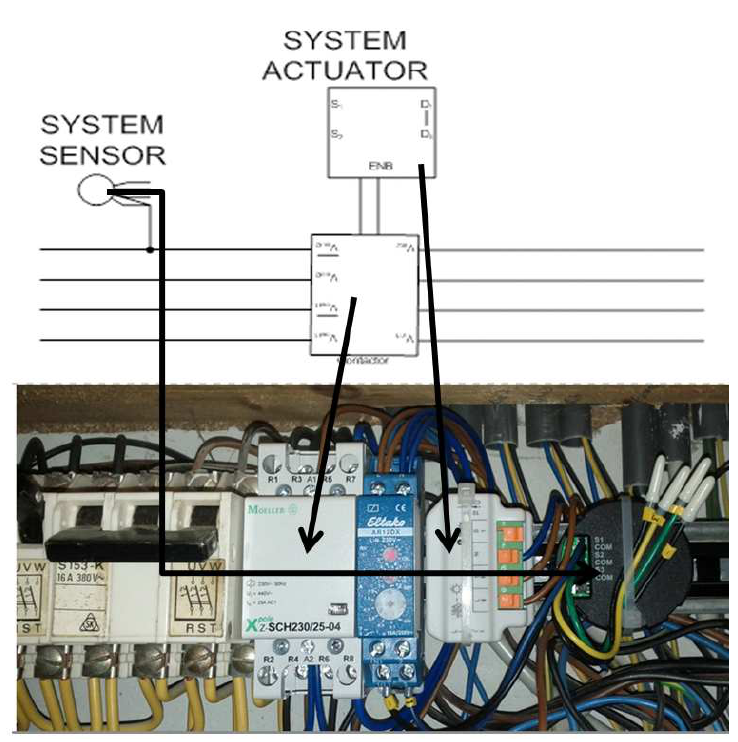
Figure 7. Kitchen stove coupled sensor/actuator